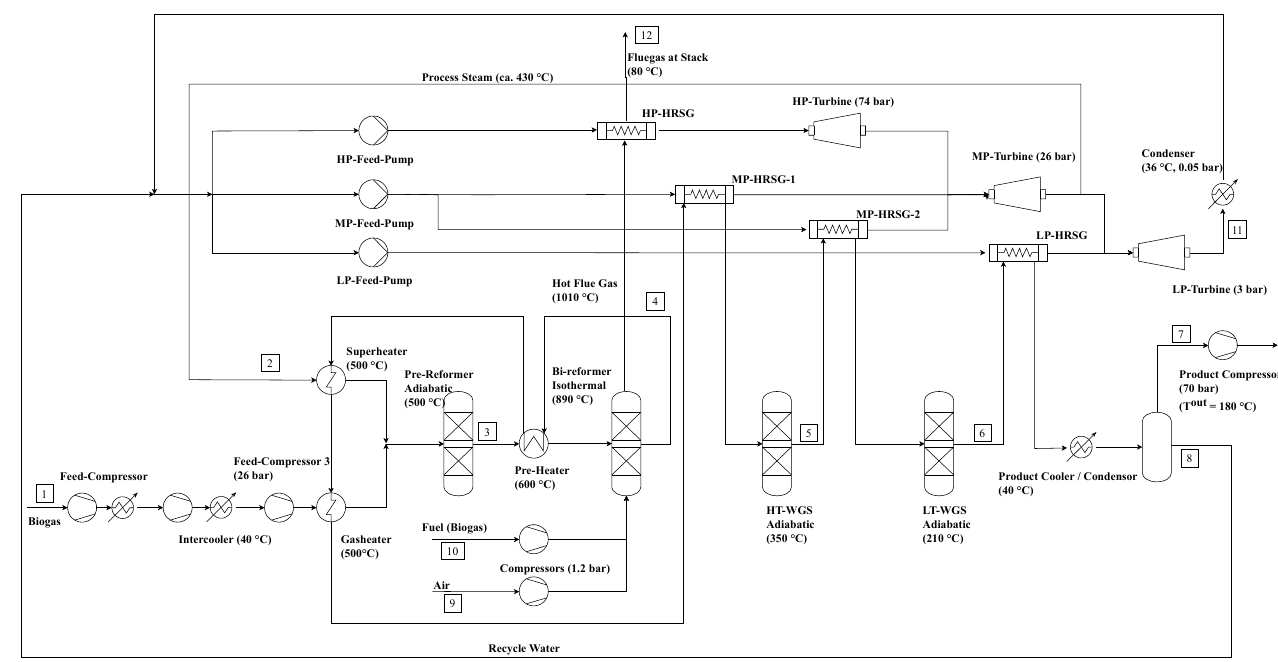
Figure 5. Process flow diagram of the bi-reforming process design.